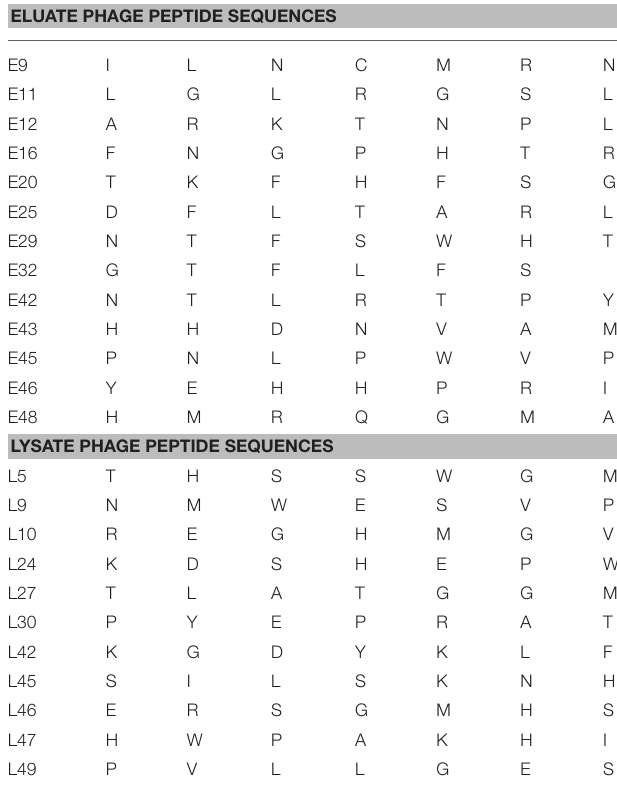
TABLE 1 | Displayed phage peptide sequences from isolated eluate and lysate phages from third round of selection against MCF/TGF β breast cancer